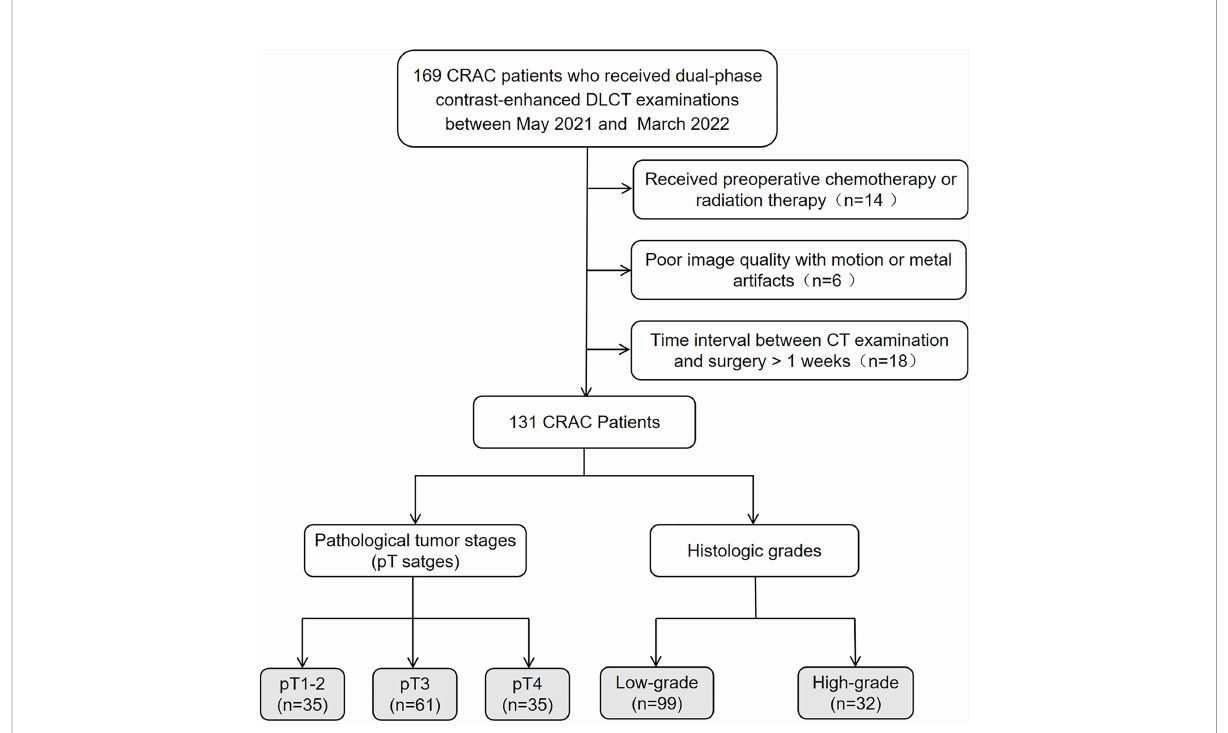
FIGURE 1 Flowchart of patient selection. CRAC, colorectal adenocarcinoma; DLCT, dual-layer spectral-detector